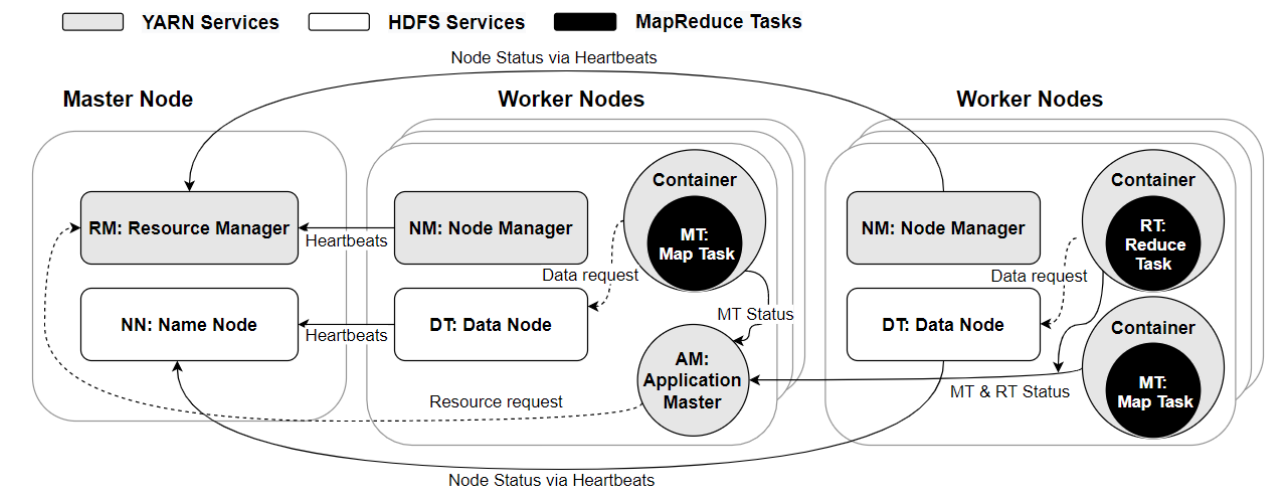
Figure 1. Interactions between HDFS, YARN and MapReduce frameworks with their